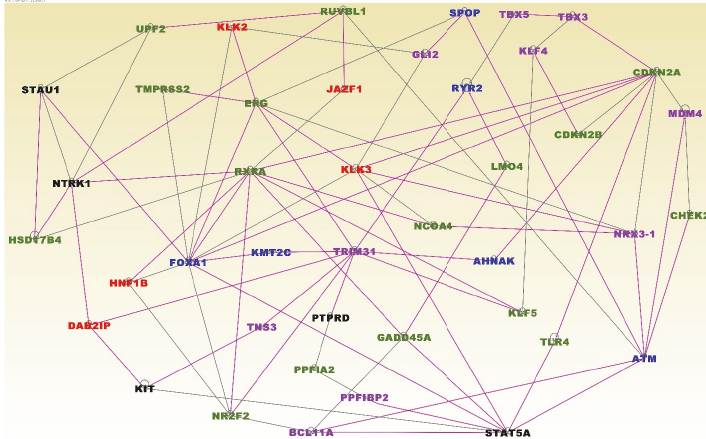
Figure 5: Molecular networks showing interactions among genes containing both germline and somatic mutations. Gene names (symbols) are presented in the nodes. Gene names in purple color font contain both germline and somatic mutations. Gene names in blue color fonts indicate genes with more > 5 somatic mutations, gene names in green font indicate genes containing germline mutations only, and gene names in red font indicate genes containing germline mutations directly associated with aggressive prostate cancer. Note that the networks were filtered to remove spurious connections. The colors red and black represent overlap in functional relations among genes in merged